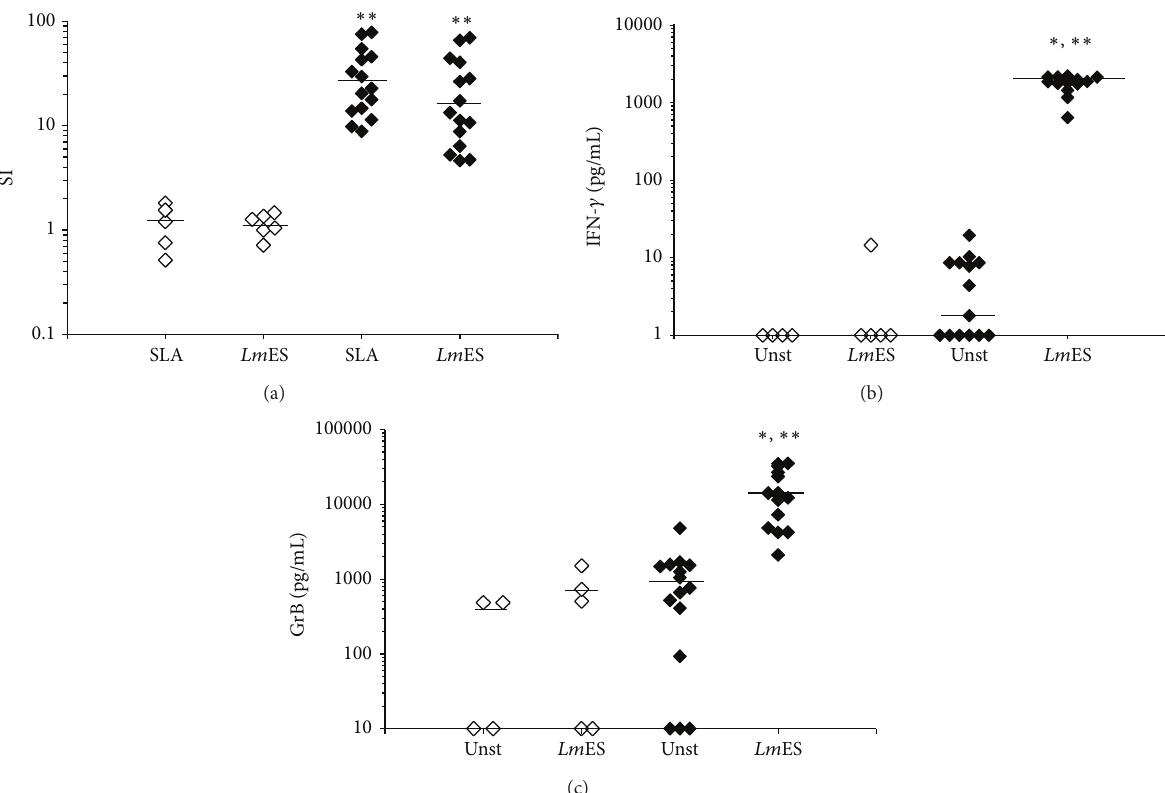
Figure 1: PBMCs response induced by Lm ES. PBMCs from HZCL and HC were stimulated with Lm ES (10 𝜇 g/mL) or SLA (10 𝜇 g/mL) during 5 days. (a) Proliferation was assessed by [ 3 H]-thymidine uptake. Results were expressed as an index of proliferation (SI) (mean counts of triplicates in antigen-stimulated cultures/mean counts of triplicates in unstimulated cultures) in all tested individuals. IFN- 𝛾 (b) and GrB (c) levels were evaluated in supernatants of cultures by ELISA tests at day 5. Results were expressed as cytokine concentrations in pg/mL. Bars represent median values. Statistical analysis: ∗ 𝑃 < 0.05 , when comparing the stimulated cells to the unstimulated cells (Unst) and ∗∗ 𝑃 < 0.05 , when comparing HZCL to